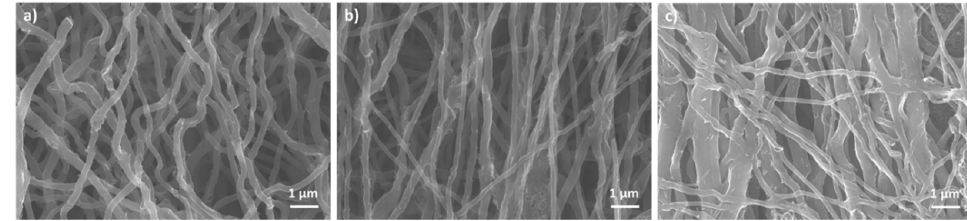
Figure 2. SEM images of carbon samples demonstrate morphologies of PAN-based carbon nano- fibers: ( a ) without mechanical treatment, ( b ) tension-induced TIPC, and ( c ) compression-induced CIPC.